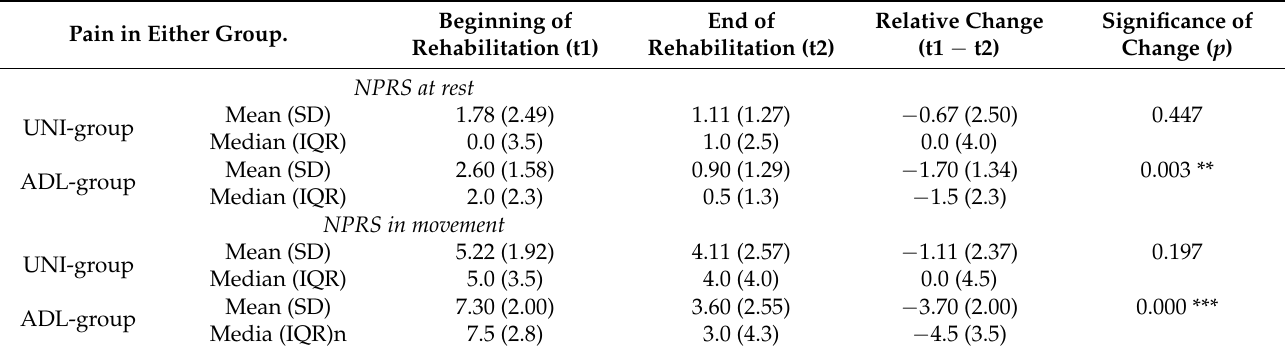
Table 3. Pain (NPRS) at rest and in movement, affected side. Pain in Either